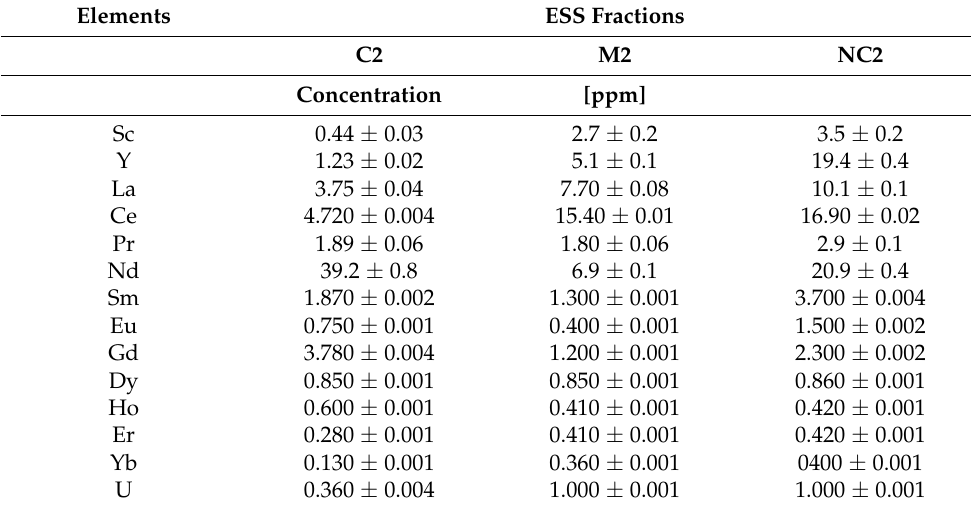
Table 9. The concentration of REEs in fractions C2, M2, and NC2 *.